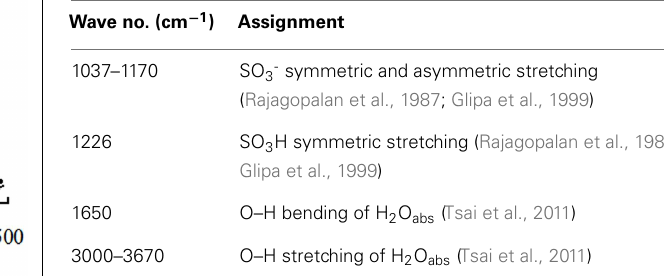
Table 1 | FT–IR assignments of PSSA